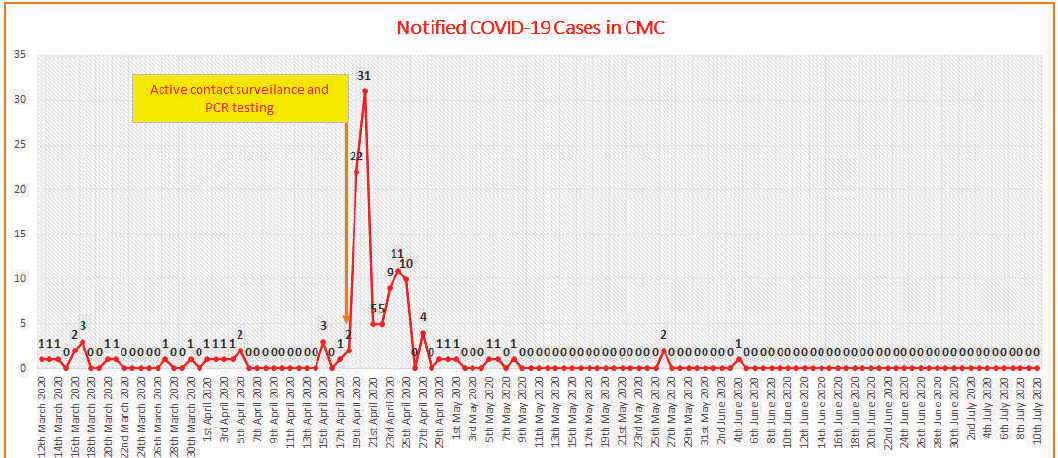
Figure 5: Notified COVID-19 cases in